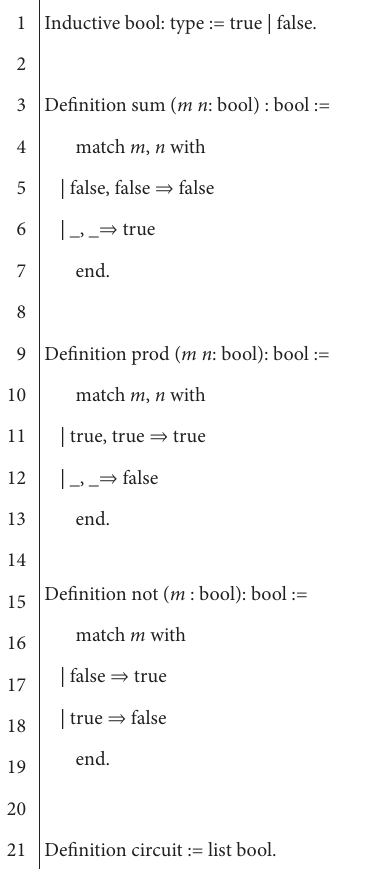
Figure 6: Formal definition of the combinational circuit